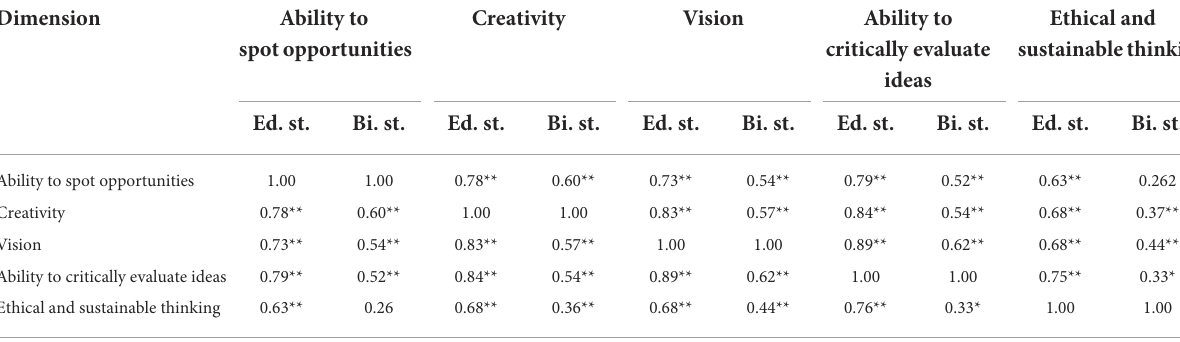
TABLE 5 Spearman’s rank correlations between all dimensions of the problem-solving skills and creativity sub-competence. Dimension